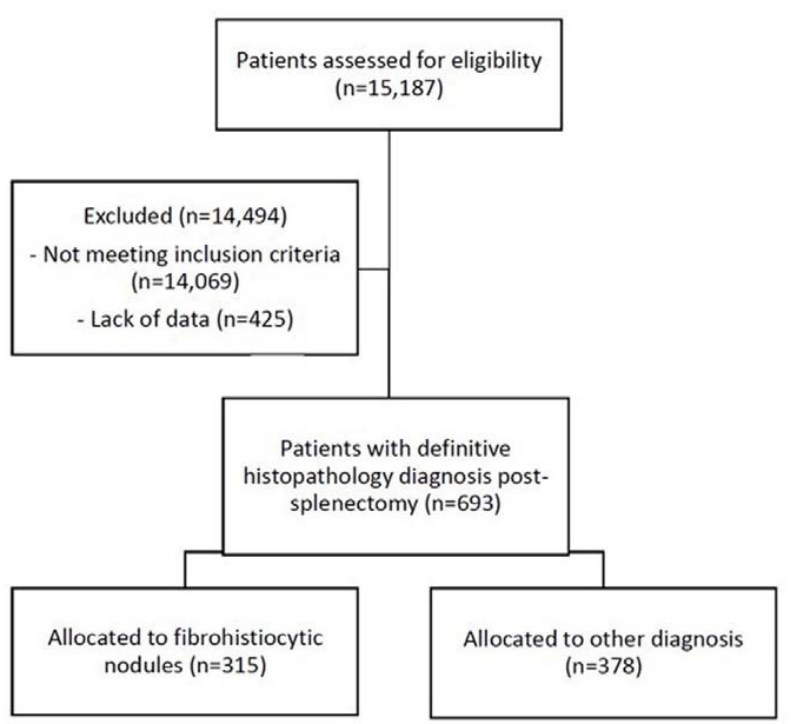
Figure 1. Flow diagram of the process of inclusion and exclusion of patients from the VetCompass Australia database in the study.